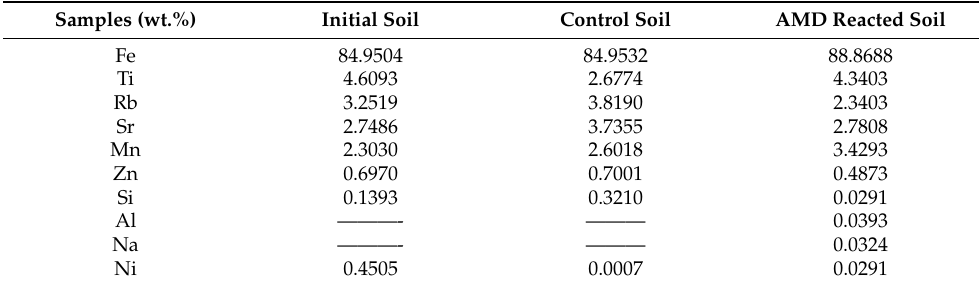
Table 3. The elemental composition of initial soil, soil from control wetland, and soil from treat- ment wetland.